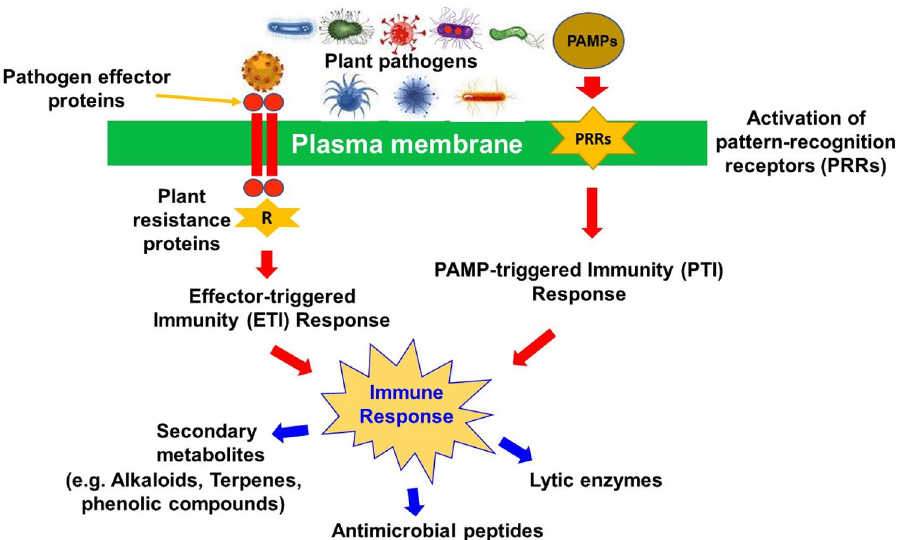
resulting in a hypersensitive response known as effector-triggered immunity (ETI). Together, these defense mechanisms result in the release of various secondary metabolites that ultimately kill the infecting pathogen. Given their novelty to human pathogens, these plant-derived antimicrobial secondary compounds can be har- nessed to combat multidrug-resistant